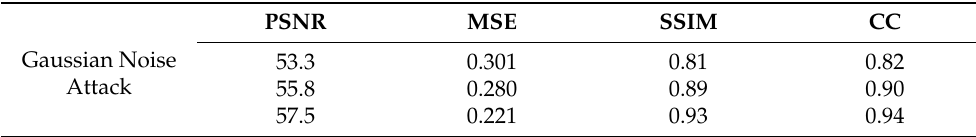
Table 6. Performance Metrics for Stego File.